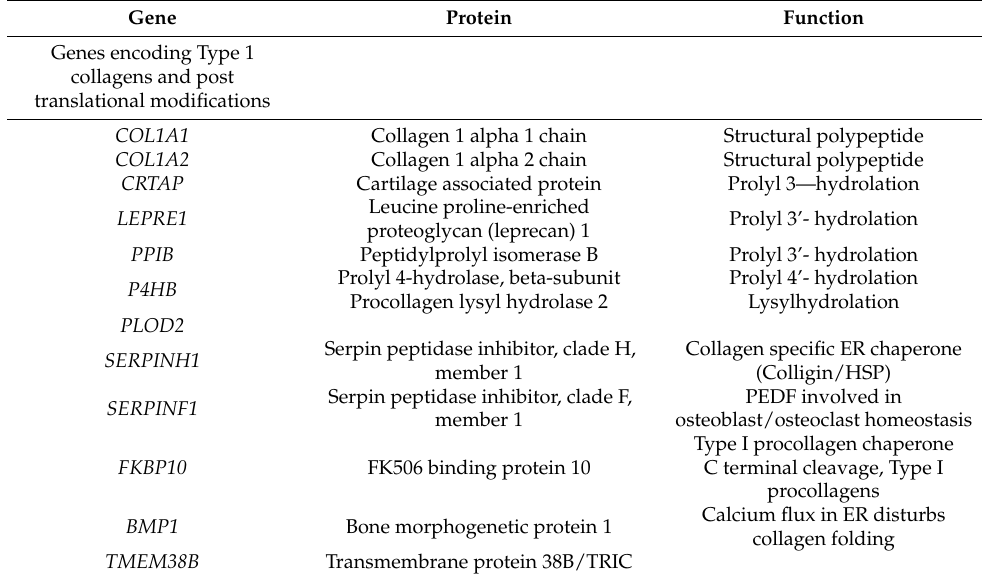
Table 4. Genes in which mutations result in at least one type of Osteogenesis Imperfecta